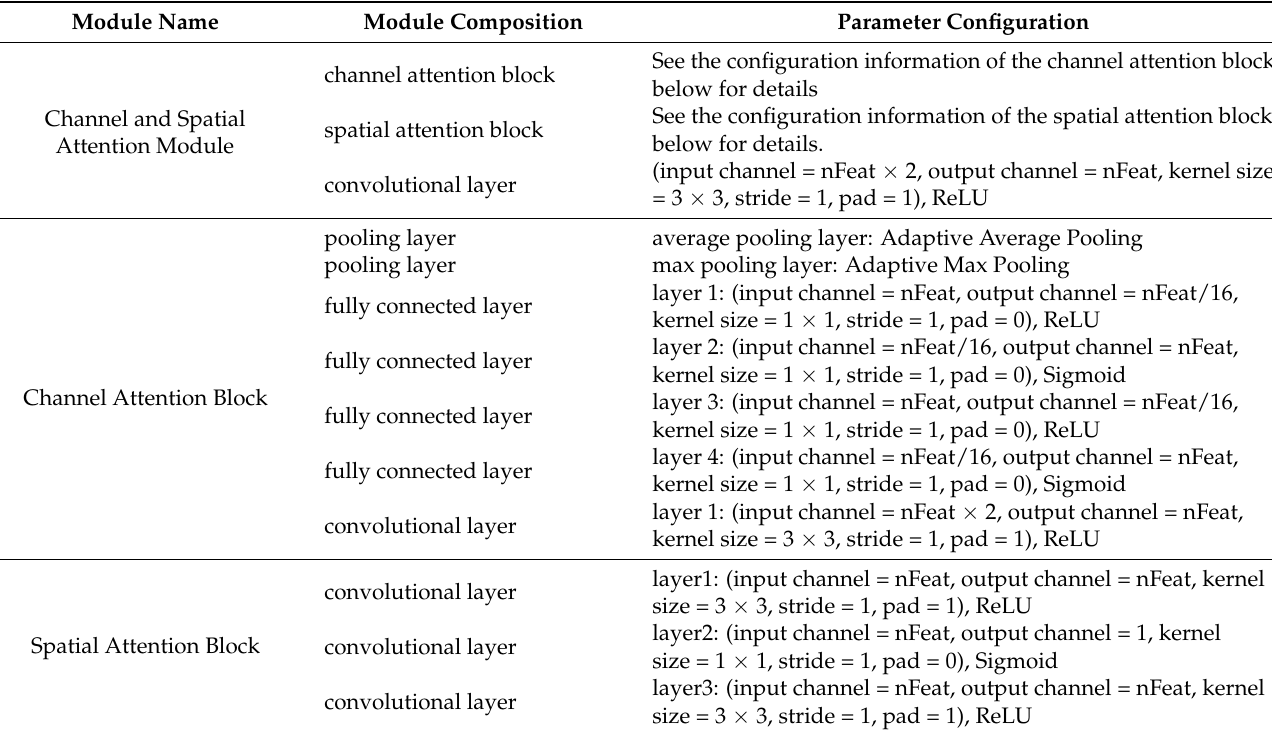
Table 1. Parameter configuration of the proposed network main